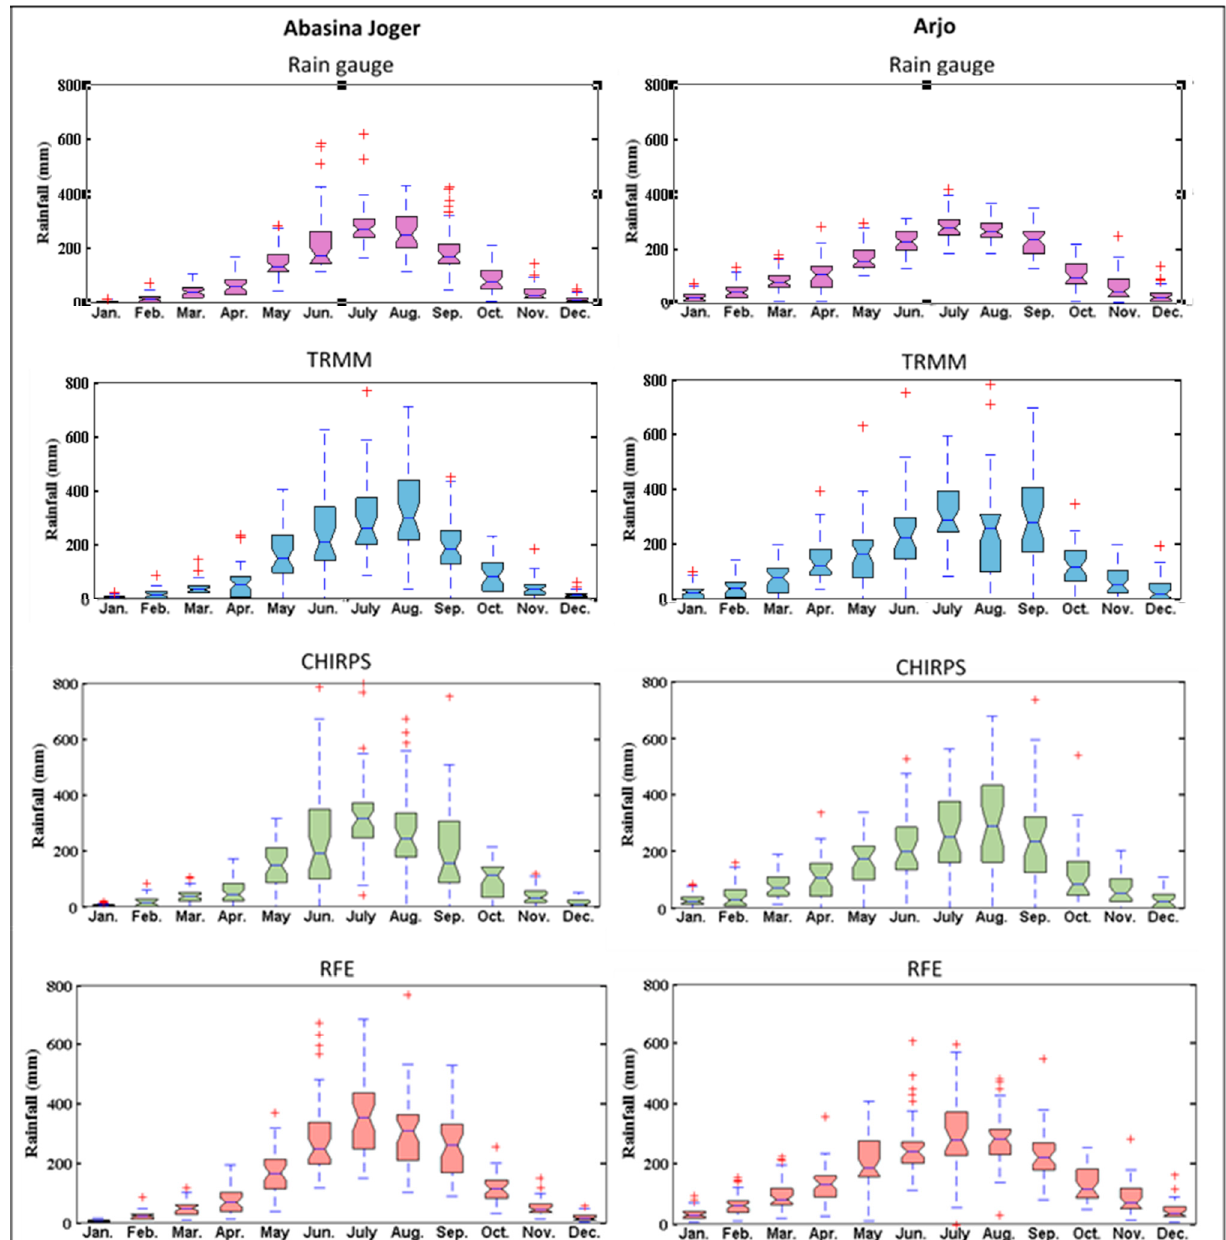
Figure 4. Box plots of monthly rainfall distributions for the satellite products and gauge records at the Abasina Joger and Arjo stations: TRMM-3B42V7 from 1998 to 2014, CHIRPS from 1981 to 2014, and RFE from 1983 to 2014.